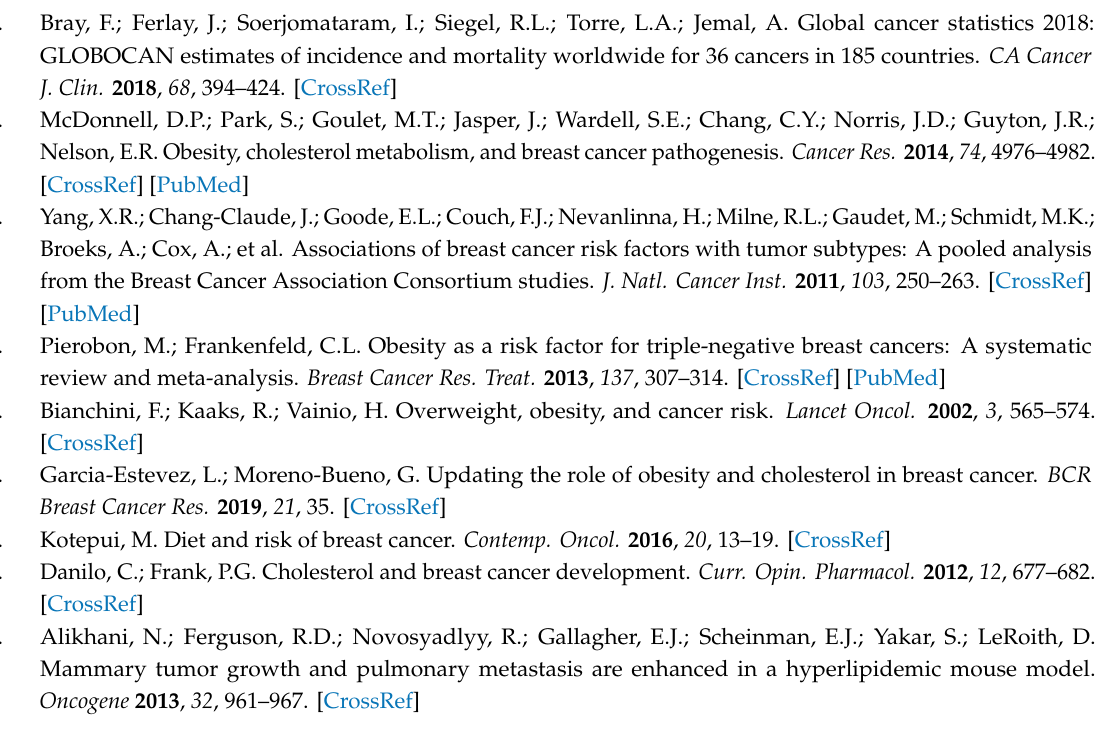
Table S1: The primer sequences used for